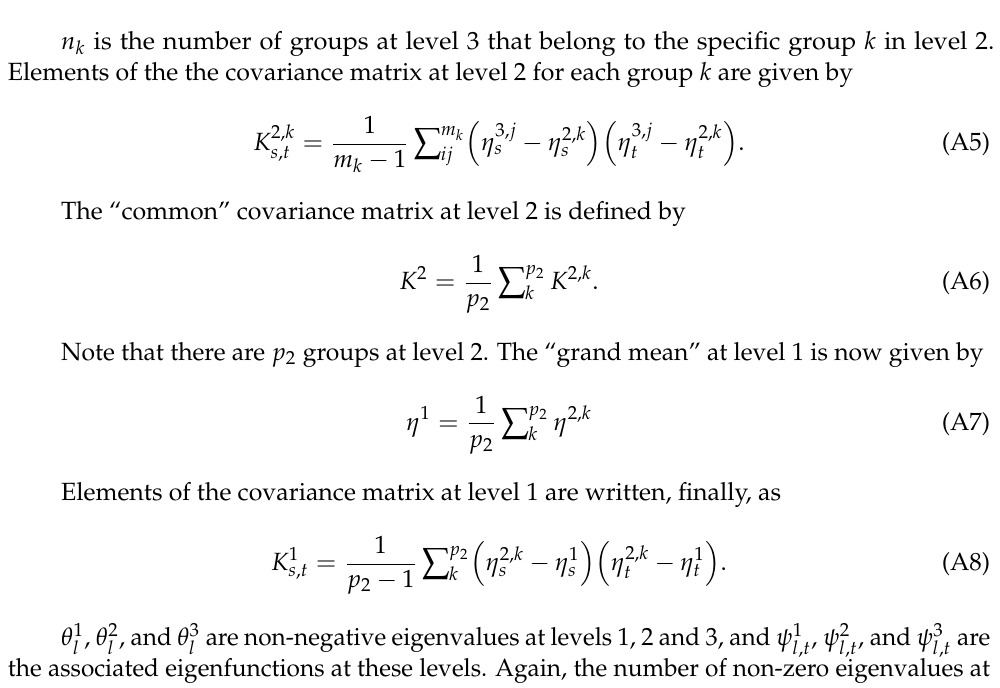
Figure A4. Example of a nested model—here, for (say) marks in a test for pupils in a school. Individual pupils are at the lowest level (level 3), where each pupil belongs to just one class in level 2. Furthermore, each class belongs to just one school. Variation can occur at all levels of the models: between pupils in each class; between classes in each school; and between schools.